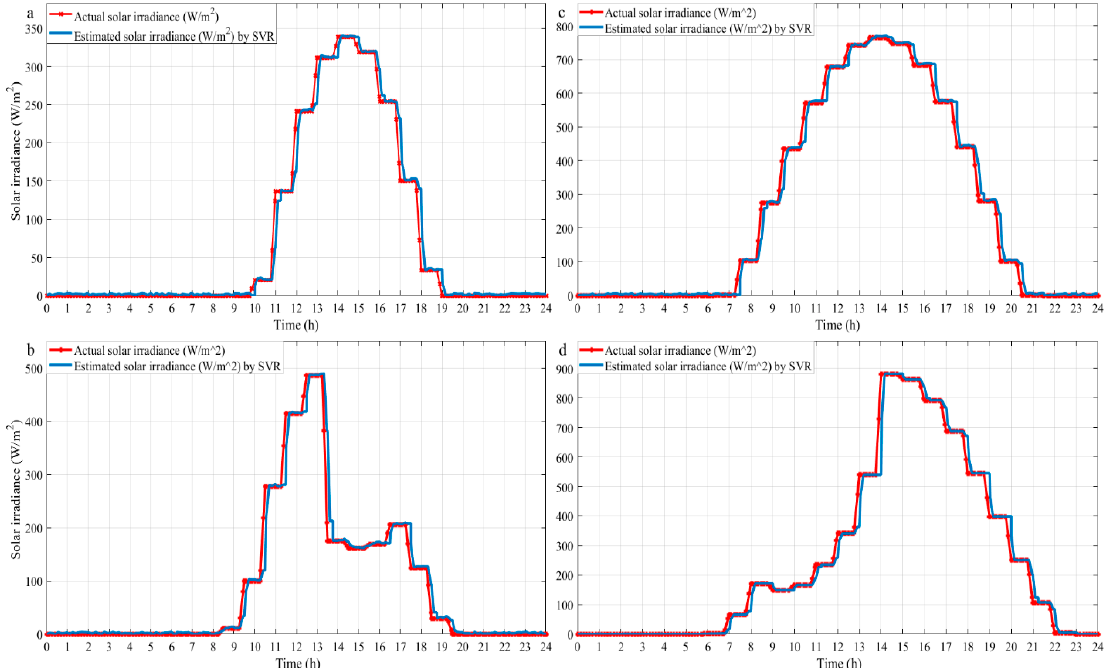
Figure 6. Prediction result of four days: ( a ) first day, ( b ) 50th day, ( c ) 100th day, ( d ) 150th day. Table 2. Performance comparison of predictor systems using predicted and actual data .